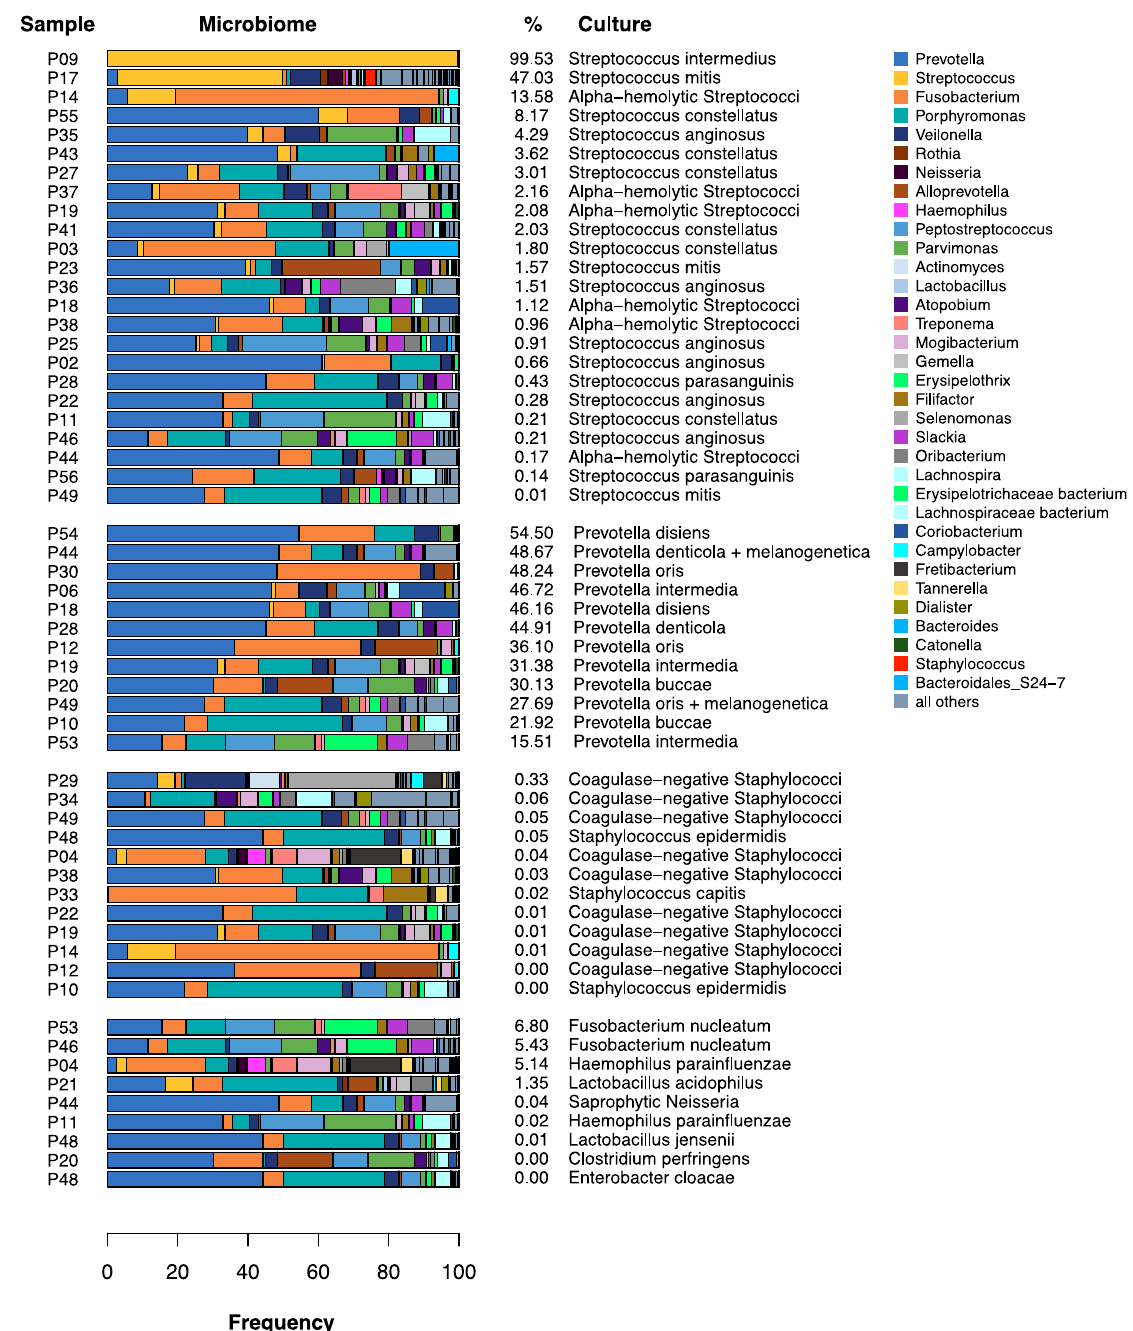
Figure 5. Culture results compared to the corresponding microbiomes. Every culturally detected bacterial species was compared directly with the corresponding microbiome. The percentage number indicates how many reads fall on the genus of the cultured species. The frequently cultured genera Streptococcus (yellow) and Staphylococcus (red) are only seen very sporadically in the microbiomes.